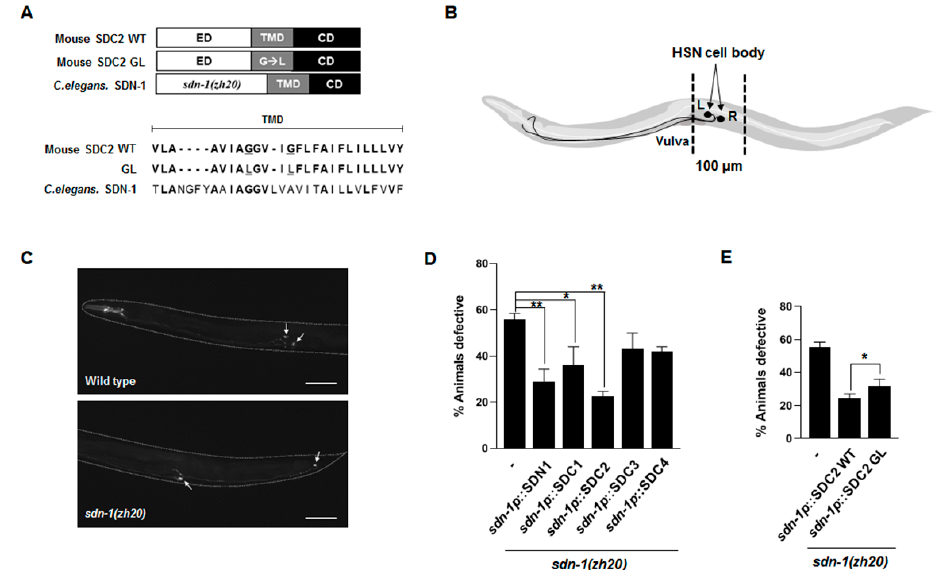
Figure 1. The transmembrane domain regulates syndecan-dependent HSN cell migration in C. elegans . ( A ) Sequence alignment of the TMD of C. elegans syndecan SDN-1 and mouse SDC2. Identical residues in at least two proteins are shown in bold. Mutation sites of the two SDC2 substitution mutant (GL) are underlined. ( B ) Schematic drawing of the HSN neurons in C. elegans . In wild-type animals, the cell bodies of two HSN neurons are located near the vulva region (L: left, R: right), and the neuronal processes run in sublateral cords to the head. In sdn-1 ( zh20 ) mutant animals, one or two cell bodies of the HSN neurons are located at the tail region. ( C ) Representative images of tph-1 p:: gfp expression in wild-type or sdn-1 ( zh20 ) mutant animals. Arrowheads and arrows indicate the vulva region and HSN cell bodies, respectively. Anterior is to the left. Scale bar: 100 µ m. ( D , E ) Shown are the percentages of HSN cell migration-defective animals for the indicated genotypes. Wild-type animals exhibit 0% defect. At least two independent transgenic lines were tested. Error bars refer to the SEM; * p < 0.05, ** p < 0.001.